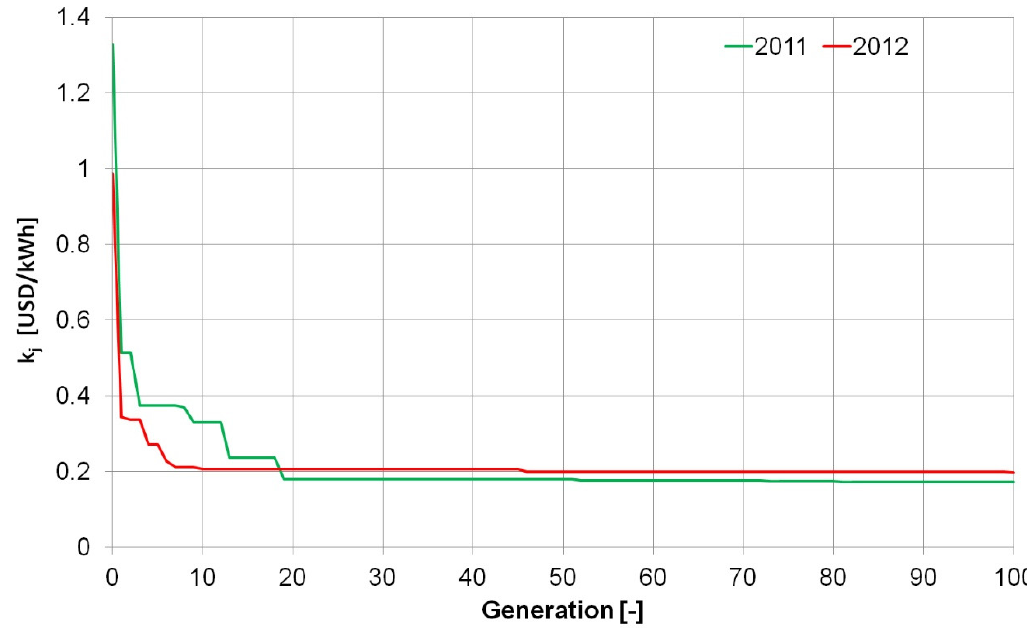
Figure 11. Evolution of the best individual quality index as a function of generation number for two optimisation tasks in 2011 and 2012 for which k L = 0. 7, T MAX = 1800 s, P 3MIN = 300 kW.